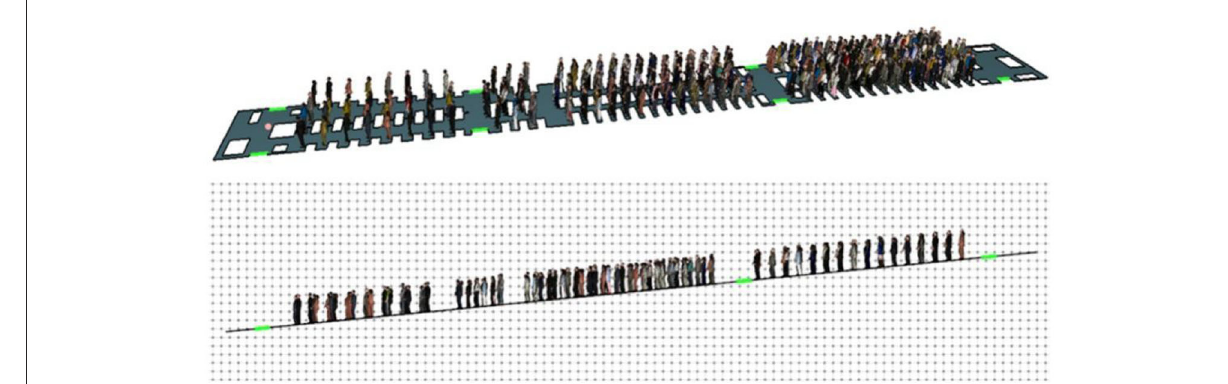
FIGURE17 Schematic diagram of the model when the cabin is tilted forward.